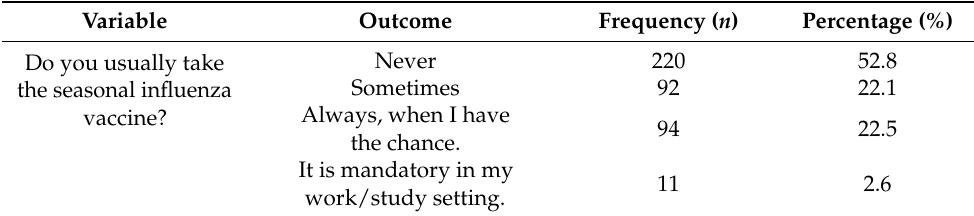
Table 3. Influenza vaccine-related experience of Palestinian dental students, February—March 2021 ( n =